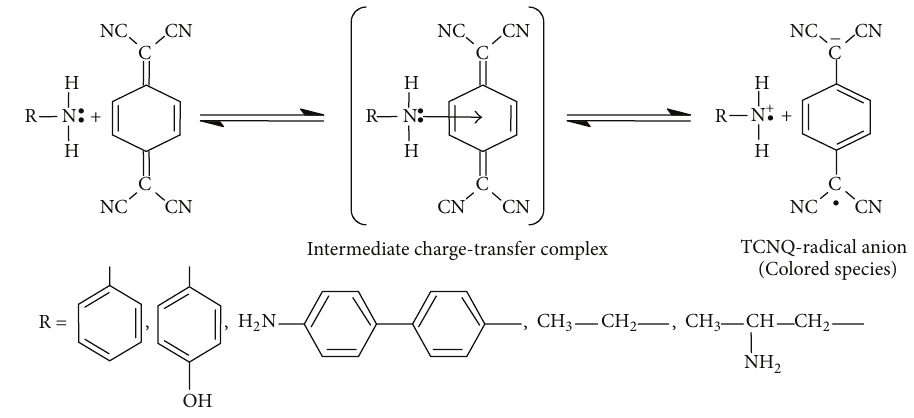
Scheme 1: Probable mechanism for the reaction of TCNQ with primary amines. Table 9: Comparison of current method with other reported methods using 𝜋